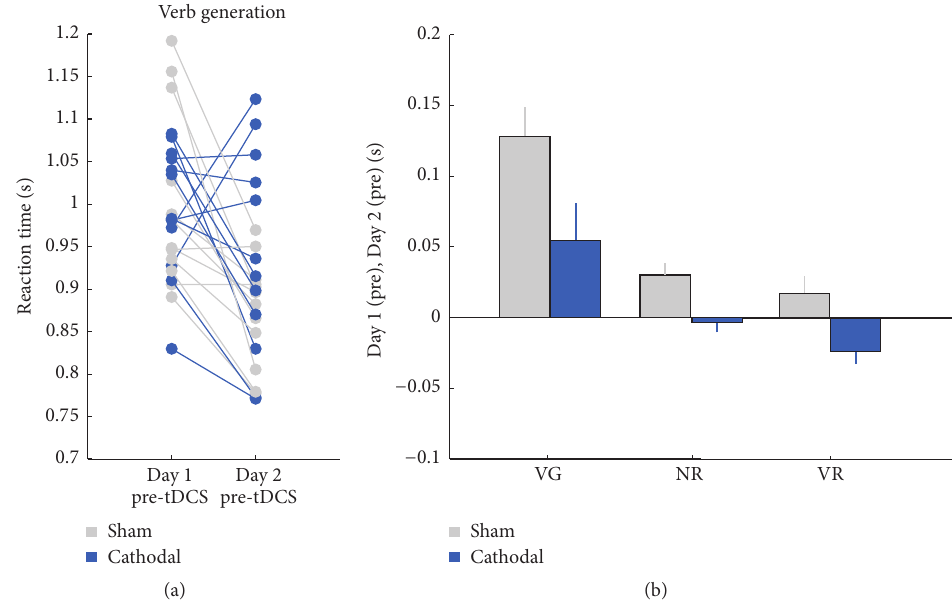
Figure 4: Results for the long term effects. (a) The individual verbal response times on the verb generation task, for visit 1 and visit 2. (b) The mean verbal response times for each task, subtracting performance in the second visit from the first visit. Error bars represent the standard error of the mean